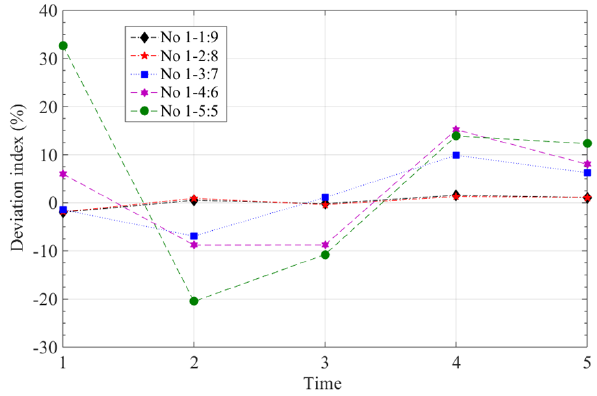
Figure 7. Results of tests of stability of polyimide film curvature sensors with different embedded depths.